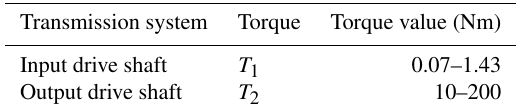
Table 4. Torque parameter table of transmission system